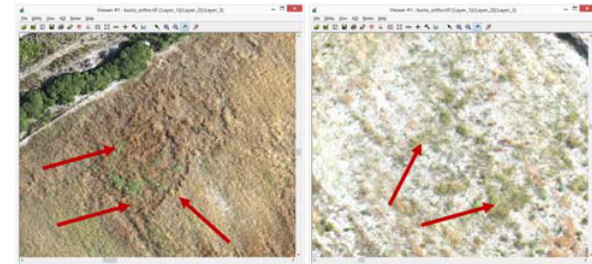
Figure 8. Detection of crop marks close to the sea as seen from the RGB ortho-mosaic